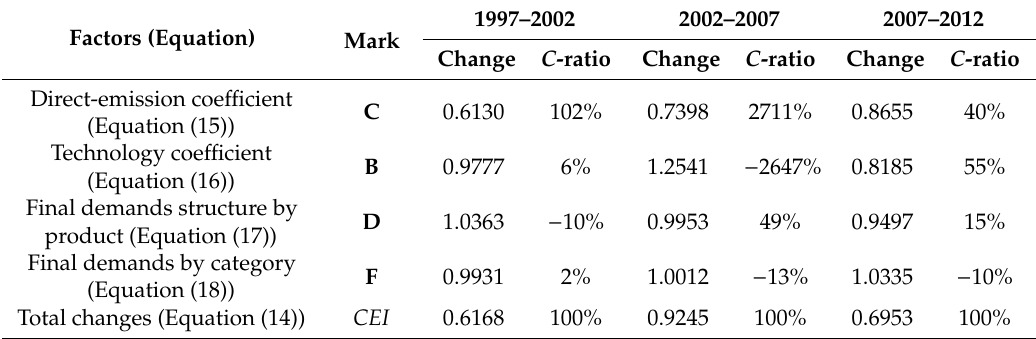
Table 4. Contributions of di ff erent factors to China’s total emission